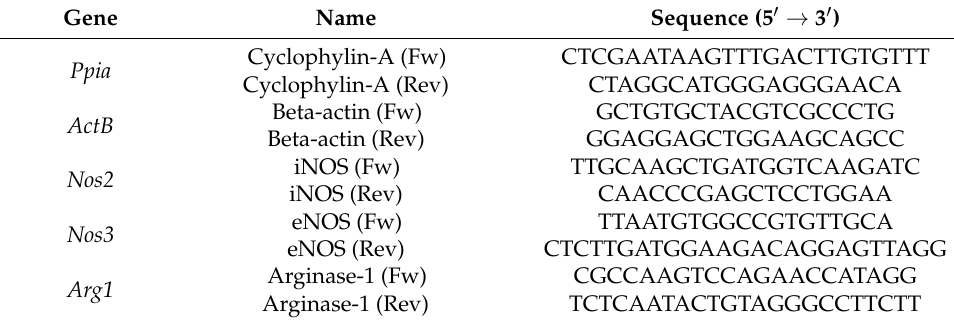
Table 2. Primer sequences for quantitative polymerase chain